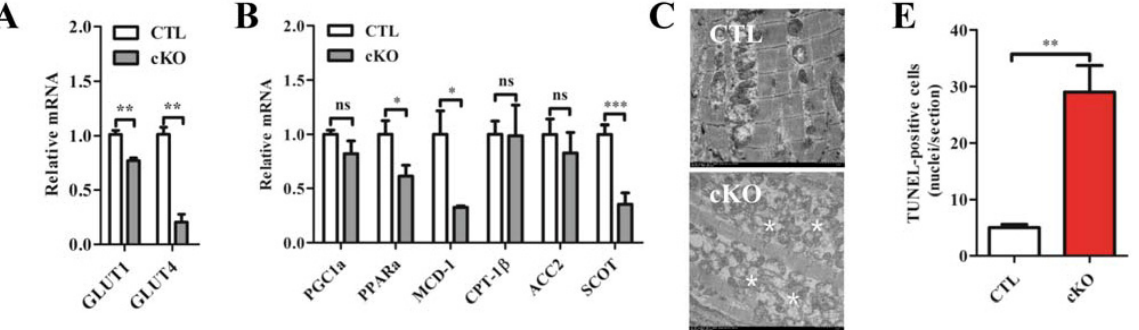
Figure 5. ( A ) Levels of expression of genes involved in glucose metabolism by qPCR at post-natal day 9 ( n = 4–6); ( B ) Levels of expression of genes involved in fatty acid metabolism by qPCR at post-natal day 9 ( n = 4–6); ( C ) Transmission electron microscope (TEM) analysis. Dysfunctional mitochondria were detected (indicated by asterisk) in cKO; ( D ) TUNEL staining. Red indicates TUNEL positive; blue indicates DAPI staining of nuclei. Original magnification: ×40 (Scale bar = 60 µm); ( E ) Quantification of ( D ) ( n = 3). ( F ) Western blot analysis of cleaved caspase 3; ( G ) Quantification of (F); ( H ) Western blot analysis of ER-associated signaling pathways in CTL and Rheb1 cKO mice at post-natal day 9; ( I – M ) Quantification of (H), ( n = 3–6); and ( N ) Detection of ER sensors at post-natal day 9 by qPCR ( n = 4–6). Abbreviations: CTL, Control group ( Rheb1 F / F ); cKO, cardiac knockout group ( Rheb1 F / F ; α MHC-Cre ); GLUT1, glucose transporter